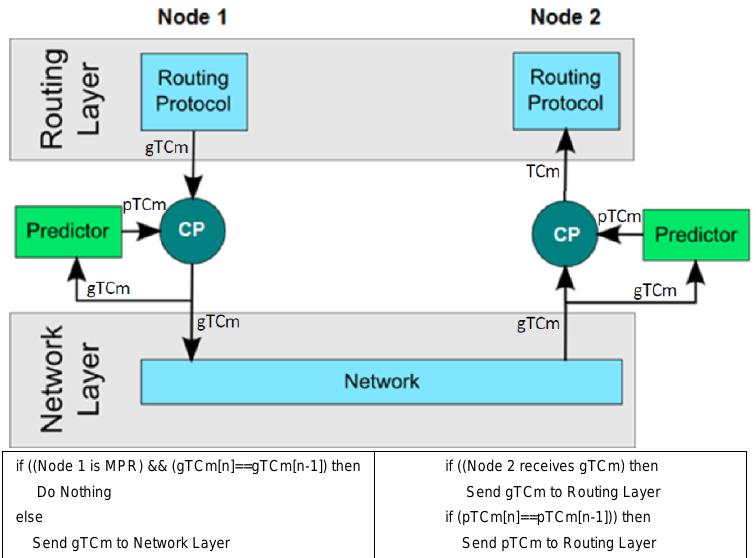
Figure 1. Network architecture including the